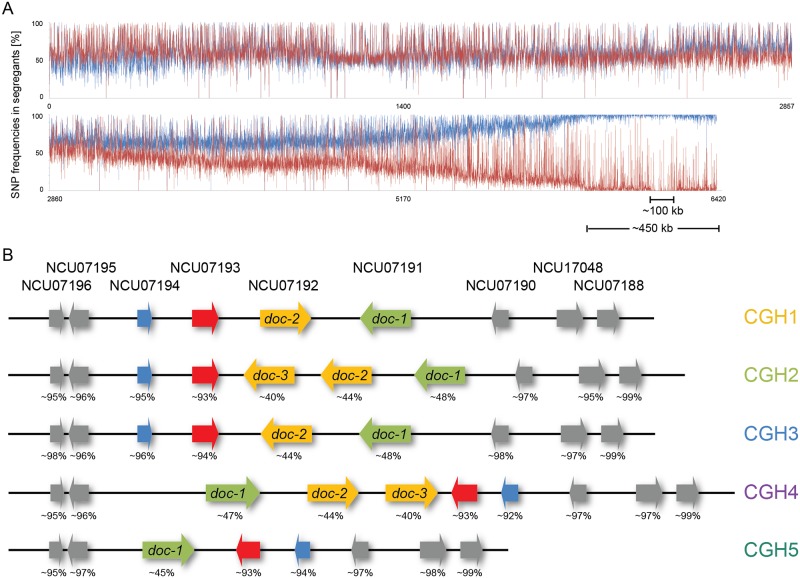
Communication group haplotypes.(A) SNP segregation on linkage group V after bulk segregant analyses and sequencing using pooled genomic DNA from 46 CG1 versus 46 CG2 progeny. Blue line: SNP frequency in pooled segregants that communicated with the CG1 tester. Red line: SNP frequencies in the pooled segregants that communicated with the CG2 tester. SNP frequencies are shown in comparison to the reference genome (FGSC 2489) [56]. (B) Genomic organization of communication group haplotypes (CGH) in wild isolates. Genomic rearrangements within the CGHs spanned the genetic interval between NCU07191 and NCU07194 and included duplications of NCU07192 (doc-2, doc-3), a deletion of NCU07192, and inversions. Alleles at NCU07191 (doc-1) and NCU07192 (doc-2, doc-3) within a CGH show high DNA sequence identity, but are polymorphic between CGHs. The percent DNA identity between alleles in members of the different CGH groups across the genetic interval in comparison to FGSC 2489 (a member of CGH1) are shown.